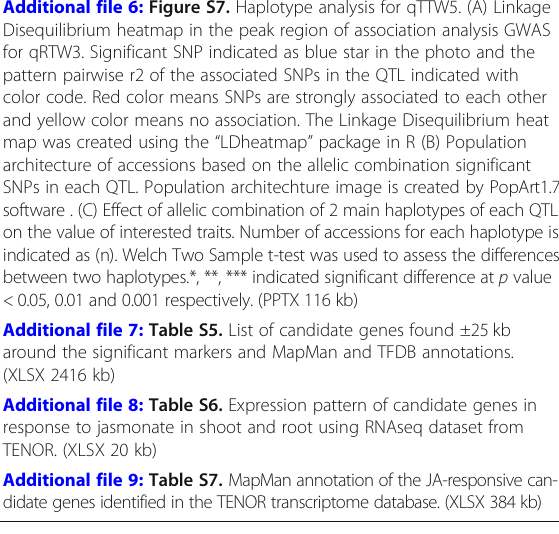
Additional file 5: Table S4. List of signification markers of detected QTLs at p -value < 3.0E-04. The start (site 1) and end positions (site 2) of each QTL were estimated by expanded 25kb to both terminals base on the LD linkage analysis. Chr for chromosome, RTW for root dry weight,